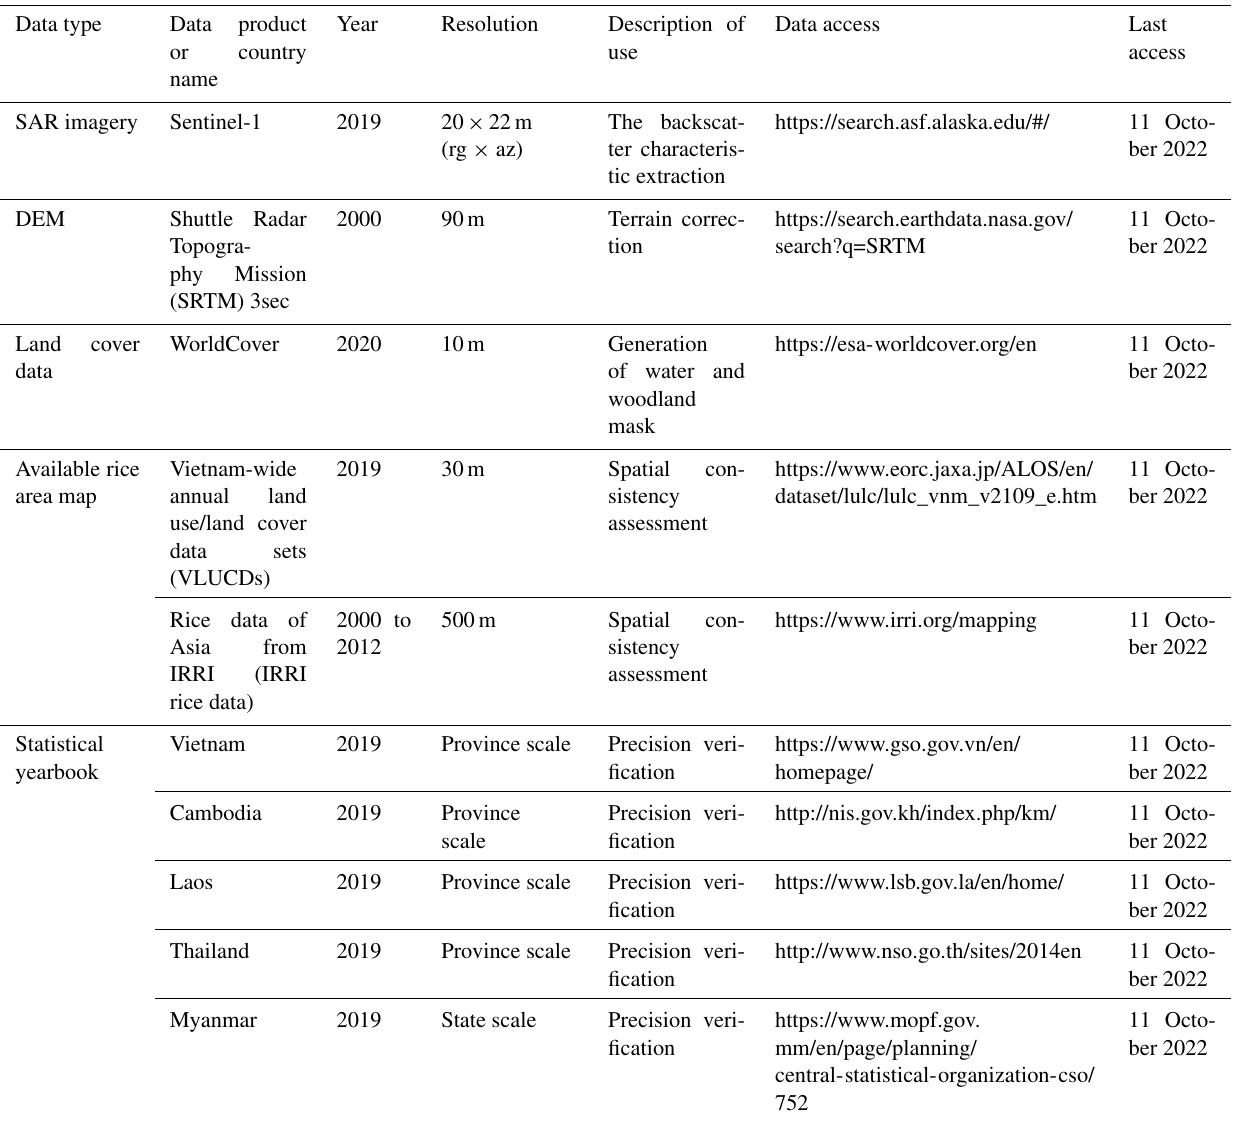
Table 2. Data information used in the